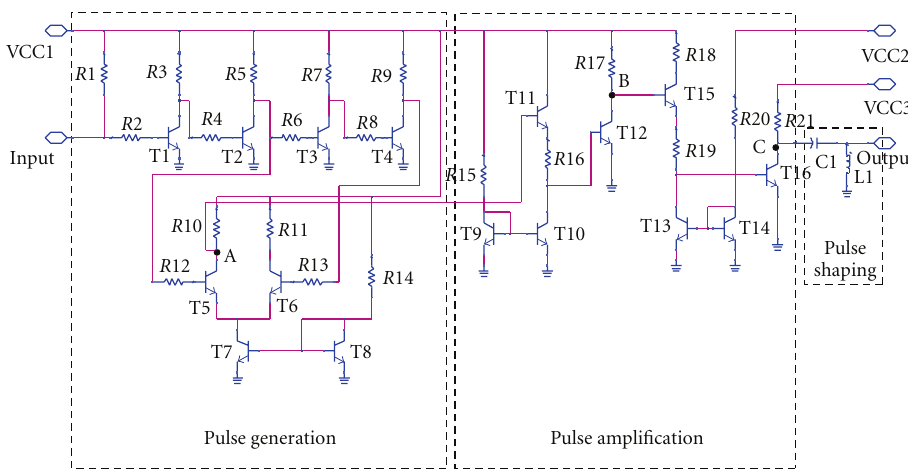
Figure 4: Circuit schematics showing the pulse generator comprises the pulse generation, amplification, and shaping